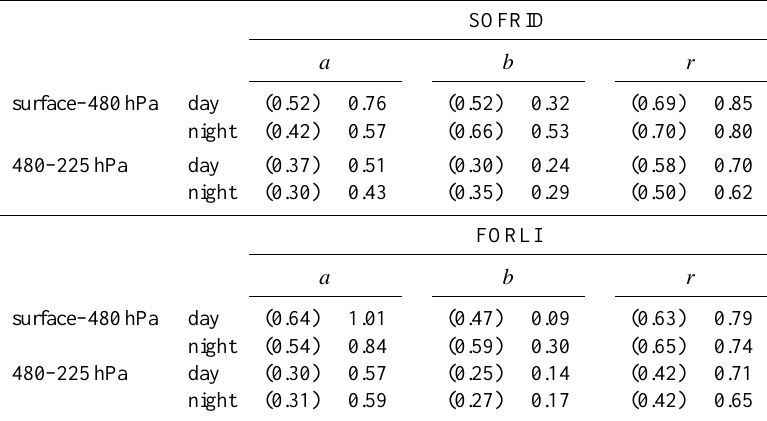
Table 2. Statistics of the comparison between smoothed MOZAIC and IASI-retrieved partial columns (SOFRID – left, FORLI – right) at Frankfurt (top) and Windhoek (bottom). Results are given for lower (surface–480hPa) and upper (480–225hPa) tropospheric partial columns. The mean ( µ ) of the relative difference and the root-mean-square of the difference (rmsd) between smoothed MOZAIC and IASI partial columns, and the IASI 1- σ measurement ( S meas ) and retrieval error ( S tot ) are given. Frankfurt SOFRID